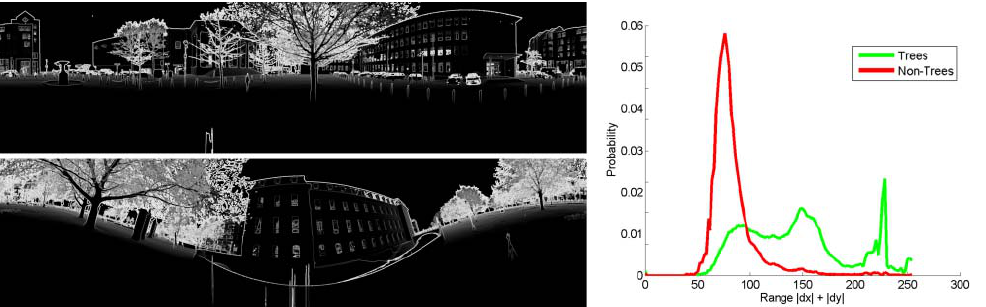
Figure 6. |dx| + |dy| values of the range channel, and their tree/non-tree